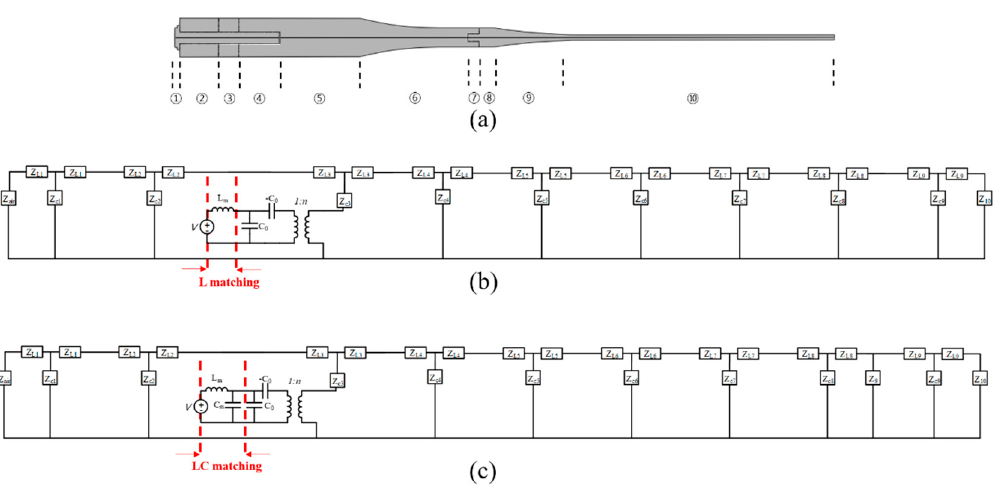
Figure 5. Overall equivalent circuit with matching circuit. ( a ) cross-sectional view of transducer, ( b ) with series L matching, ( c ) with LC matching.